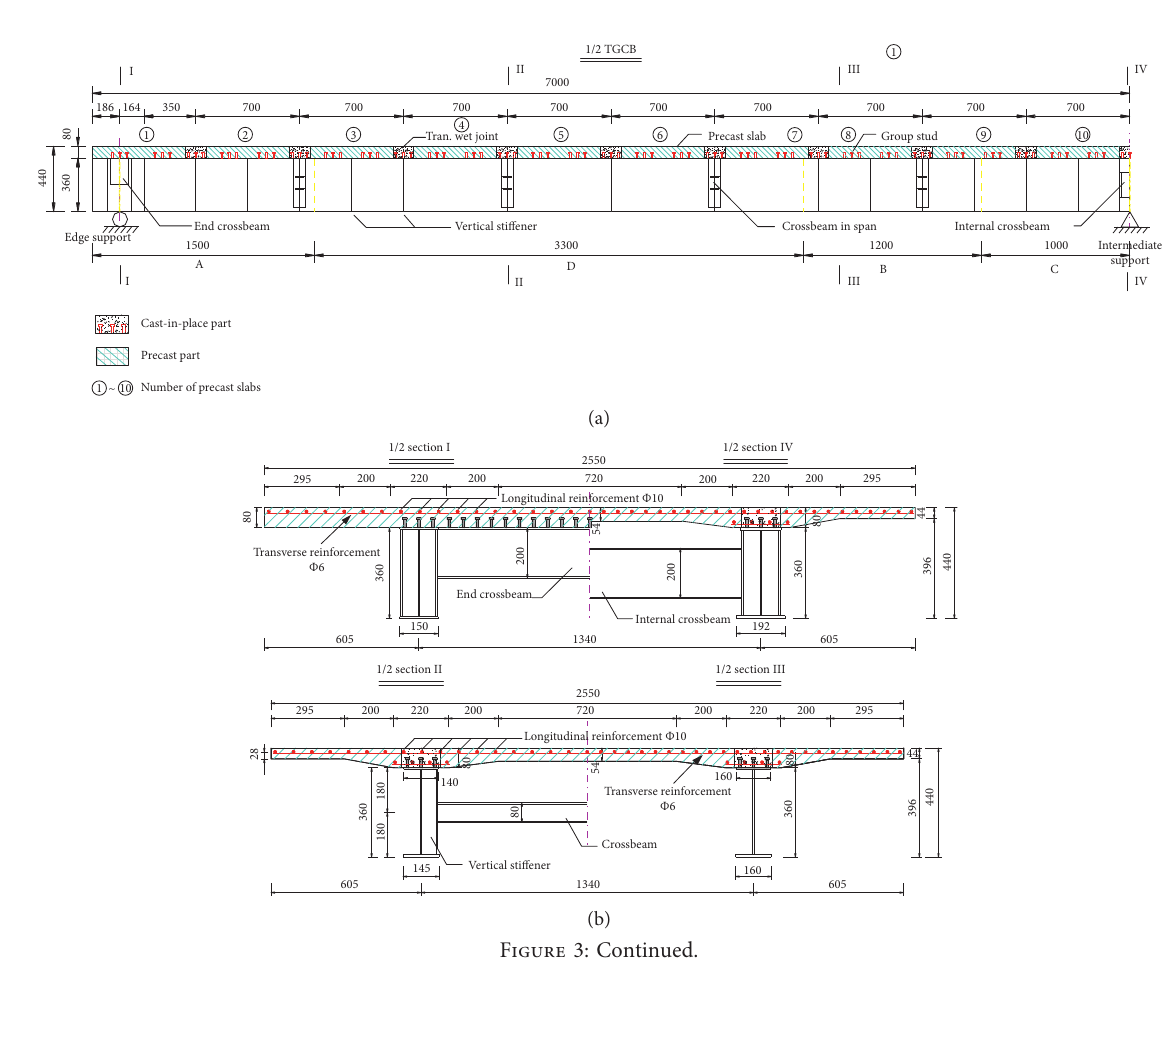
Figure 2: Prototype